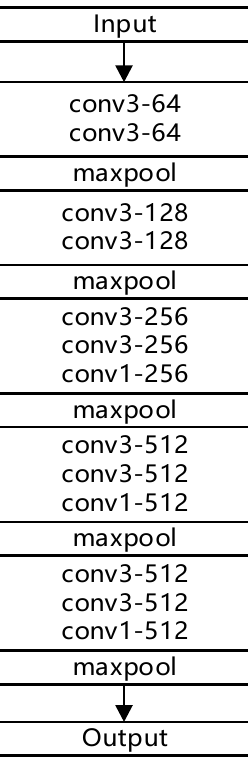
Figure 6. Structure of the VGG16 feature extraction network.